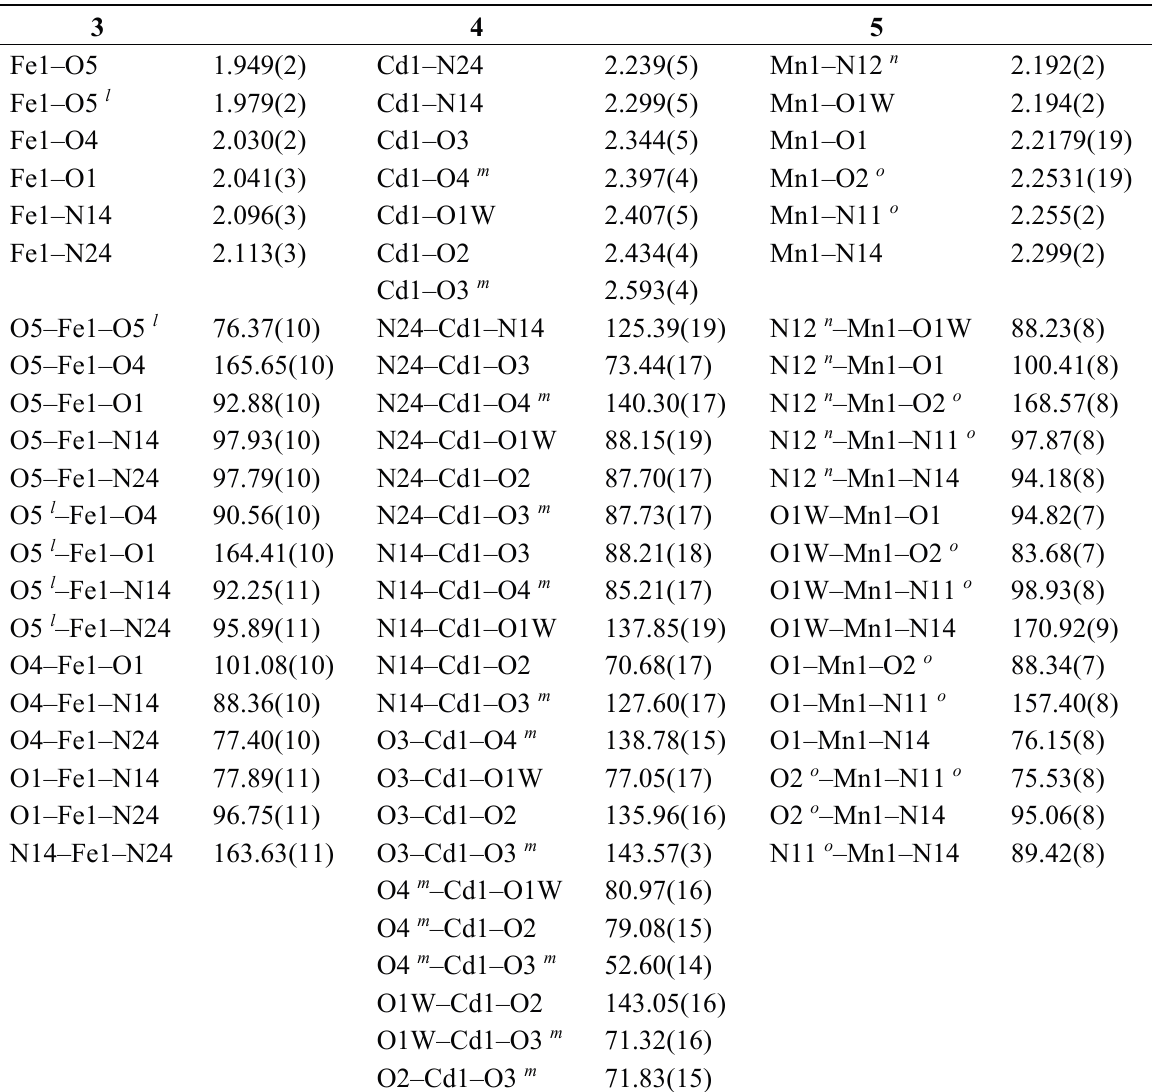
Table 3. Selected bond lengths (Å) and angles (°) of the binuclear complex [Fe 2 (Hatrc) 4 (OH) 2 ] present in compound 3 , and of the coordination networks [Cd(Hatrc) 2 (H 2 O)] n ( 4 ) and [Mn(atrc)(H 2 O)] n · n H 2 O ( 5